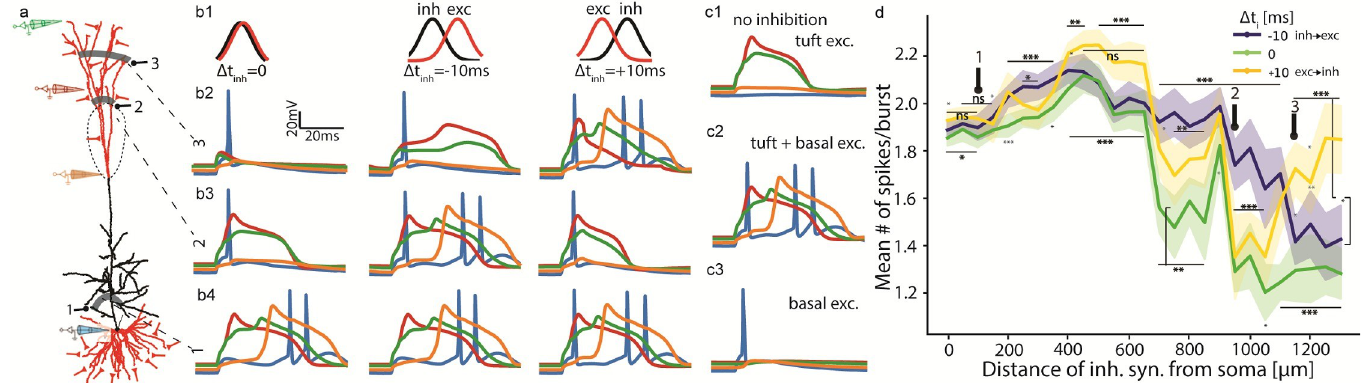
Fig 5. Impact of dendritic inhibition on burst generation. The case of whole apical tuft activation with dendritic inhibition distributed at strips of iso-distance from soma. a. Schematics showing the distribution of synapses. Inhibitory synapses at all locations of a fixed distance from the soma (a single numbered grey shaded strip). Synapses #1 at 100 μ m from the soma on the oblique branches; synapses #2 at 950 μ m from the soma on the intermediate apical tuft and synapses #3 at 1150 μ m on the distal apical tuft. Electrodes correspond to colored voltage traces in b . b1. Normalized distribution of synaptic activation times separated for excitatory and inhibitory inputs, with different delays Δ t inh for the three columns shown. b2-b4. Voltage traces for inhibition at distances 1, 2 and 3, respectively. c1-c3. Control cases. c1. Forty excitatory synapses activated at the tuft triggers NMDA spikes but no dendritic Ca +2 spike nor somatic spikes. c2. Excitatory input to both basal (70) and tuft (40) dendrites generates an NMDA- (red/green) and a Ca 2+ spike (orange) and, in turn, a somatic burst of Na + spikes (blue). c3. Seventy excitatory synapses activated at basal dendrites generate a Na + spike. d. Mean # of spikes in a burst as a function of the distance of inhibition from the soma. Lines correspond to different Δ t inh values as in b 1. Shaded regions show standard deviation of 10 batch means (of 20 repetitions each; see Methods ). P-values between Δ t inh = 0 and +10 ms are marked below green lines, Δ t inh = 0 and -10 ms above blue lines, and Δ t inh = ± 10 ms above yellow lines. � p < 0.05, �� p < 0.01, ��� p < 0.001. Unmarked are not significant (ns; p > 0.05). Excitatory synapses are as in Fig 4 (70 basal and 40 tuft), but distributed on the entire tuft, activated simultaneously ( Δ t = 0) with σ = 10 ms (see Methods ). In each inhibitory stripe shown in a , 20 inhibitory synapses were activated in a 200 μ m uniform distribution around all branches at each distance from the soma